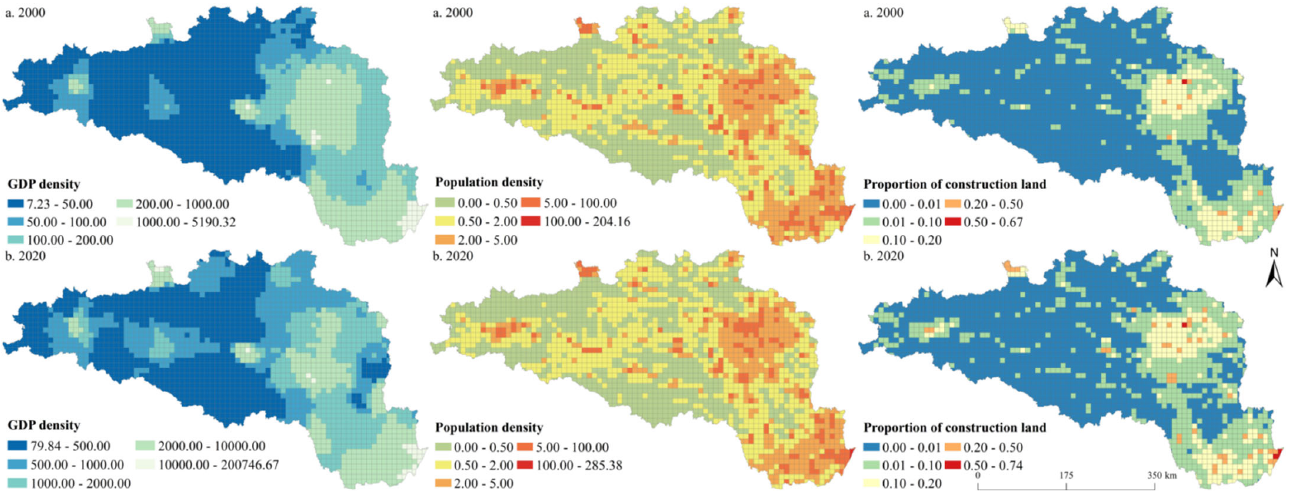
Figure 5. Spatial pattern of urbanization elements at the 10 km grid scale in the HREEB in China.